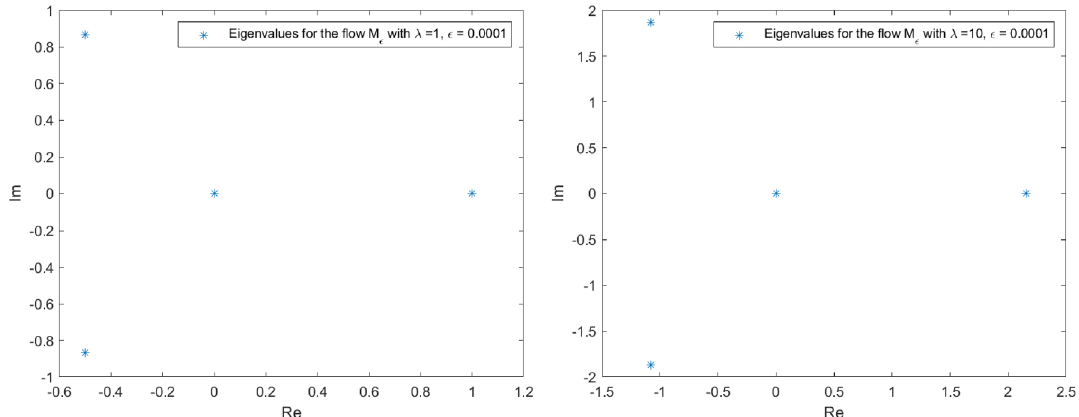
Figure 5. M ǫ eigvenalues evolution for (cid:31) = 1 (left) and (cid:31) = 10 (right). Note that c = 1 and q = 2 . A solution in B r ( 0 ) can be obtained by linear combination of the exponential bundles associated to each eigenvalue.